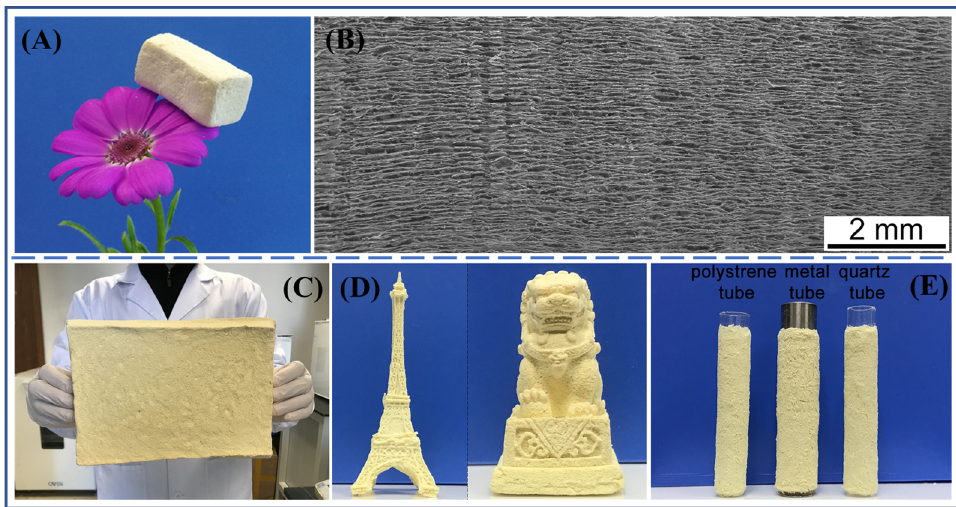
Figure 11. ( A ) Photograph of the laminated PANF aerogel [42]. ( B ) The inner structure of the laminated PANF aerogel [42]. Copyright 2019 American Chemical Society. ( C ) Large cuboid PANF aerogel (220 mm × 150 mm × 40 mm) [79]. ( D ) PANF aerogels with sophisticated shapes: left, Eiffel Tower; right, Chinese stone [79]. ( E ) Different materials coated with PANF aerogel. From left to right: polystyrene tube, metal tube and quartz tube [79]. Copyright 2021 American Chemical Society.